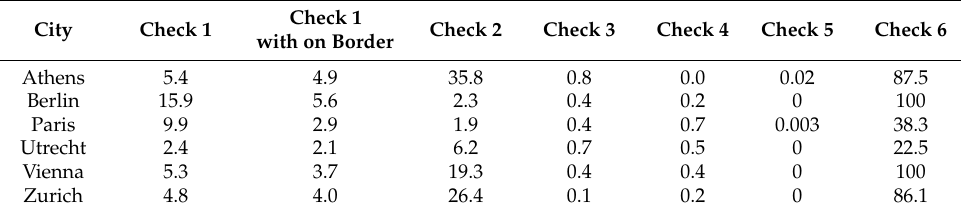
Table 5. Percentage of POIs checked and error percentages for each check and